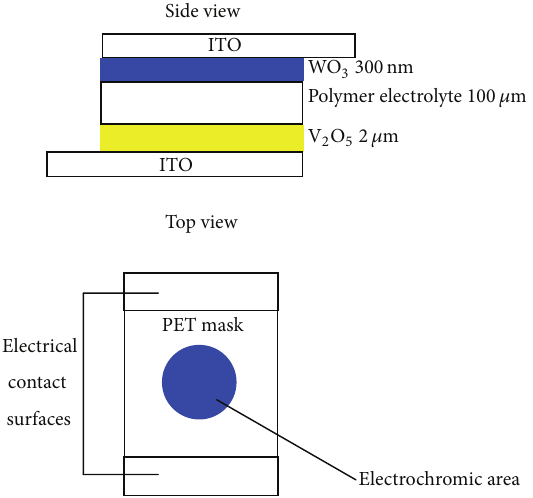
Figure 2: Schematic illustration of ECD prepared in this